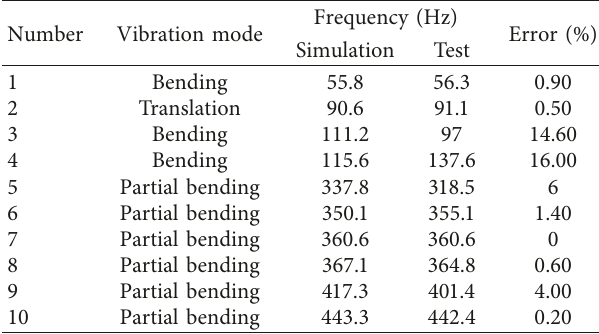
Table 6: Natural frequencies and vibration modes of test and